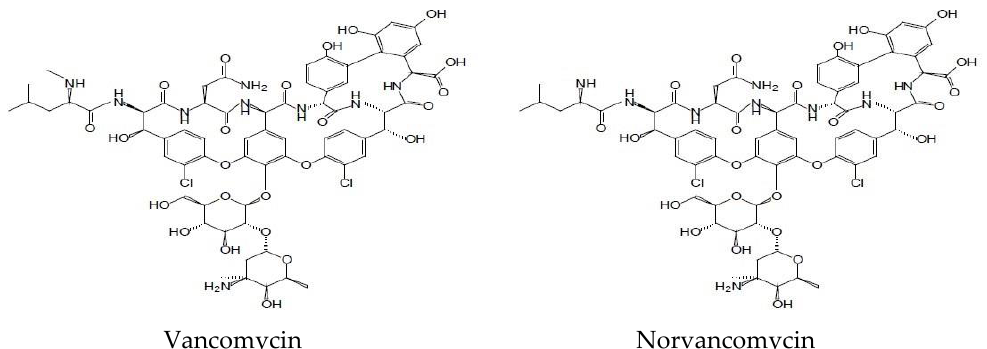
Figure 1. Structure of vancomycin and norvancomycin.